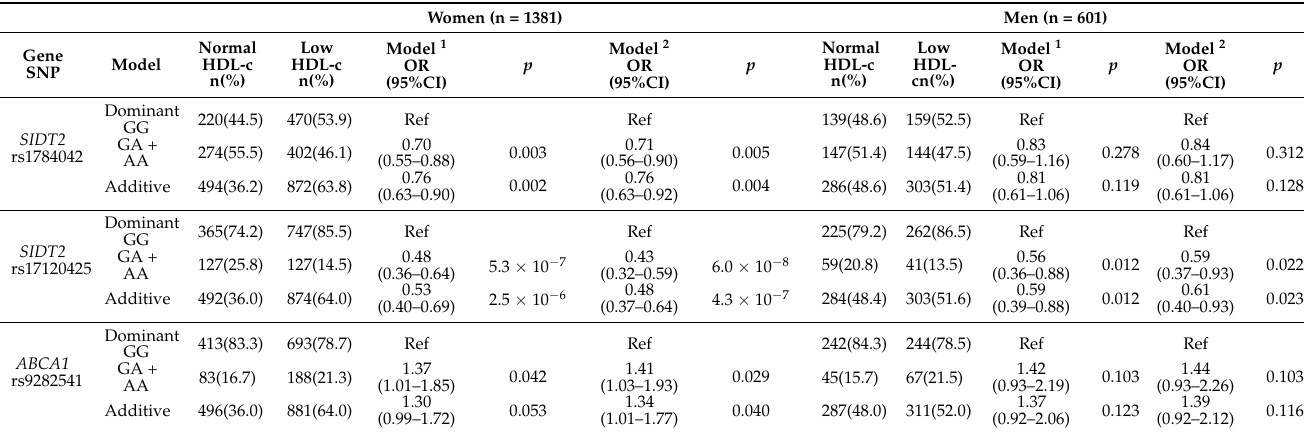
Table 4. Association between rs1784042, rs17120425, and rs9282541 polymorphisms and HDL-c stratified by sex.